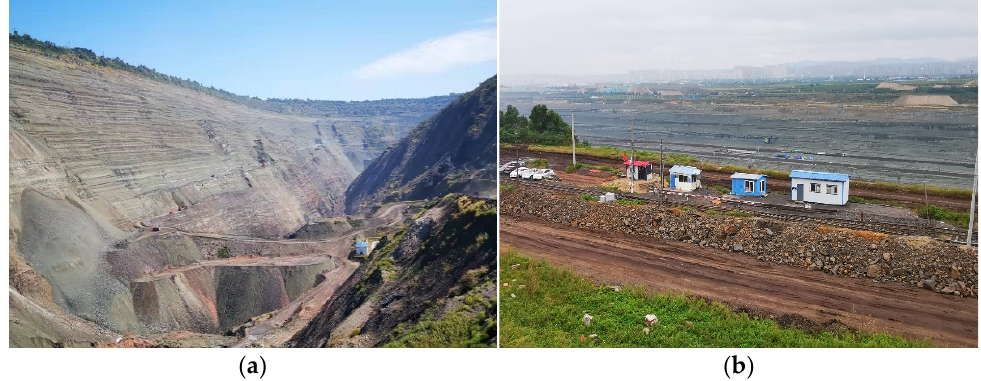
Figure 1. Site picture of Laohutai Mine. ( a ) Schematic outline of the mine site; ( b ) road and railroad diagram of the mining area.